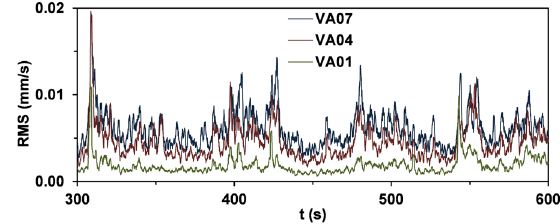
Figure 25. PSDs at Stern’s buttress in radial direction4.